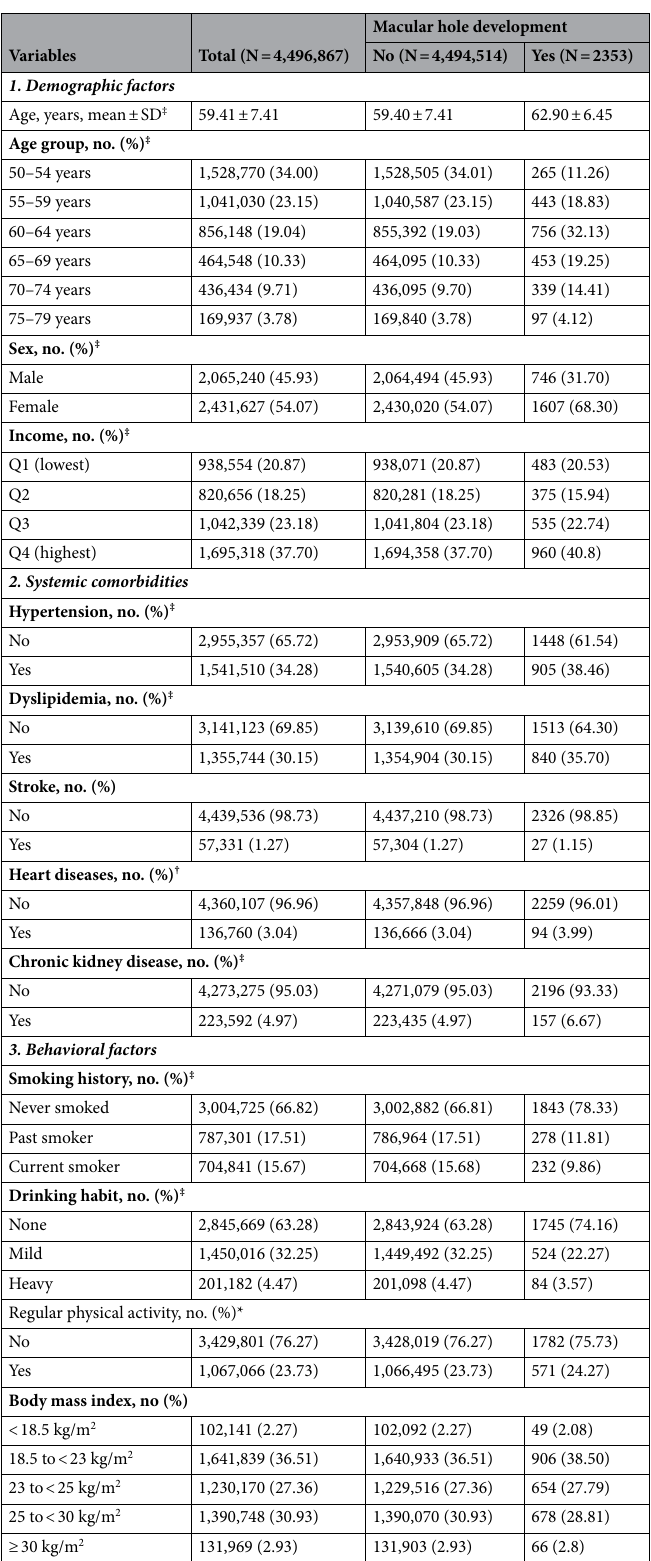
Table 1. Baseline characteristics of the study subjects for Analysis 1. SD standard deviation, Q quartile. *p-value < 0.05; † p-value < 0.01; ‡ p-value <